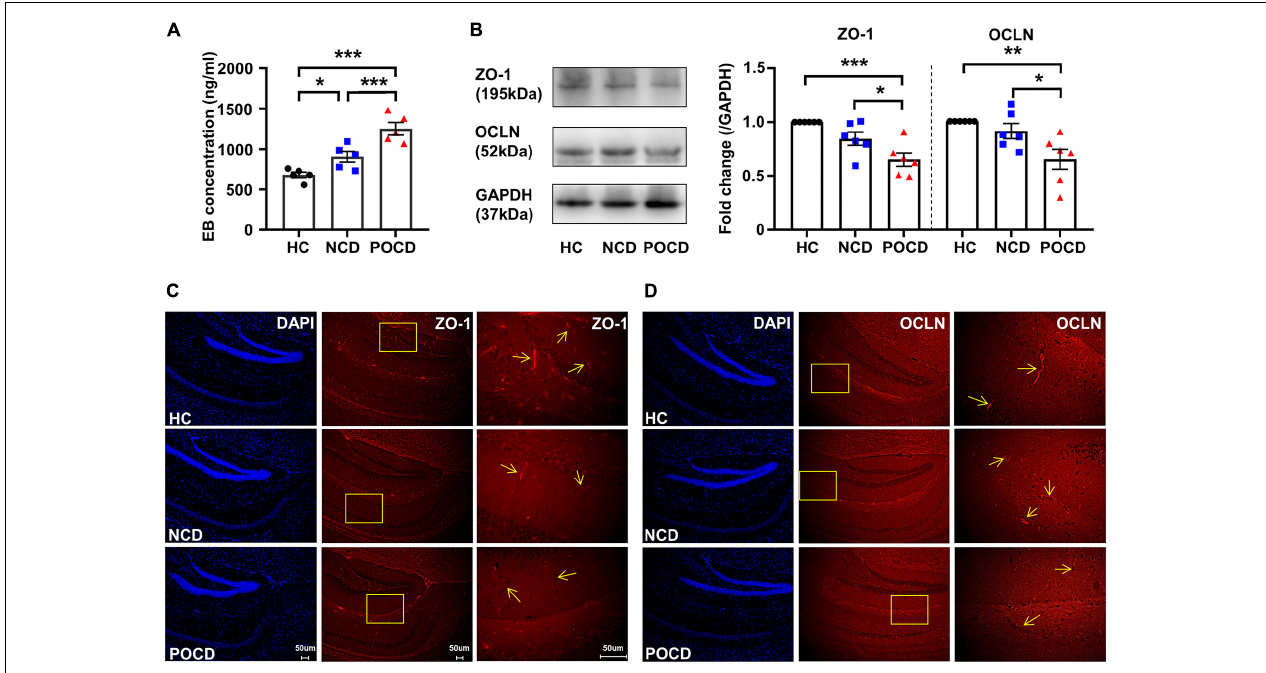
FIGURE 2 | Increased blood-brain barrier (BBB) permeability and decreased expressions of tight junction proteins in POCD. (A) Hippocampal Evans blue (EB) concentrations of mice in HC, NCD, and POCD groups. (B) Representative bands and quantitation of ZO-1 and OCLN proteins in the hippocampi (relative to GAPDH). (C) Representative images of DAPI and ZO-1 in the hippocampus for immunofluorescence. (D) Representative images of DAPI and OCLN in the hippocampus for immunofluorescence. Data are shown as mean ± S.E.M. (for EB assay, n = 5 in each group; for western blot and immunofluorescence, n = 6 in each group). * P < 0.05, ** P < 0.01, or *** P < 0.001. EB, Evans blue; GAPDH, glyceraldehyde phosphate dehydrogenase; HC, healthy control; NCD, non-POCD; N.S., not significant; OCLN, occludin; POCD, post-operative cognitive dysfunction; ZO-1, zonula occludens